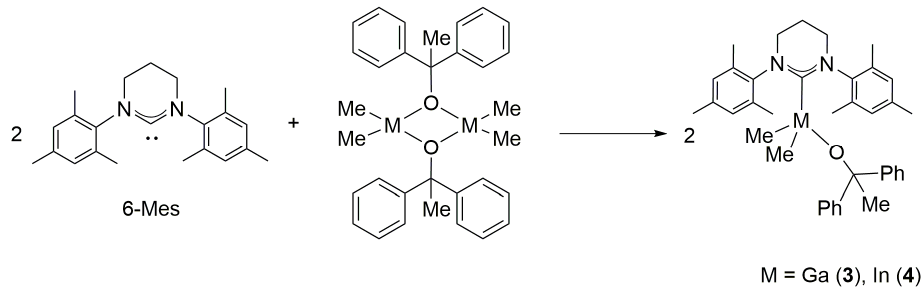
Scheme 3. Synthesis of Me 2 M(OCPh 2 Me)(6-Mes) complexes (M = Ga,